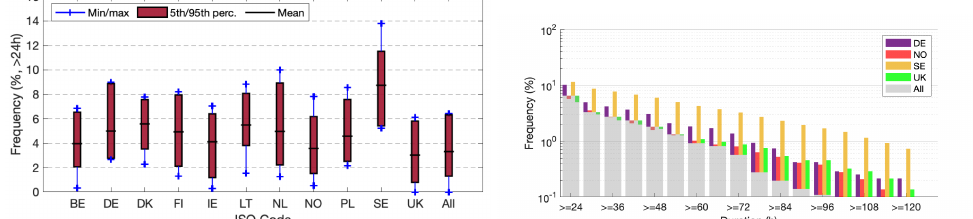
Figure 8. ( Left panel): frequency boxplot of Dunkelflaute events (longer than a day) for individual countries and where wind and PV generation are pooled in an interconnected system of eleven countries (labeled as ‘All’). ( Right panel): frequency distribution of Dunkelflaute events for four representative countries (Germany (DE), Norway (NO), Sweden (SE), and the UK) and an inter- connected system (labeled as ‘All’). The frequency for the interconnected system is given by gray bars, while the frequency for the four individual countries is shown in color as a deviation from the magnitude of the interconnected